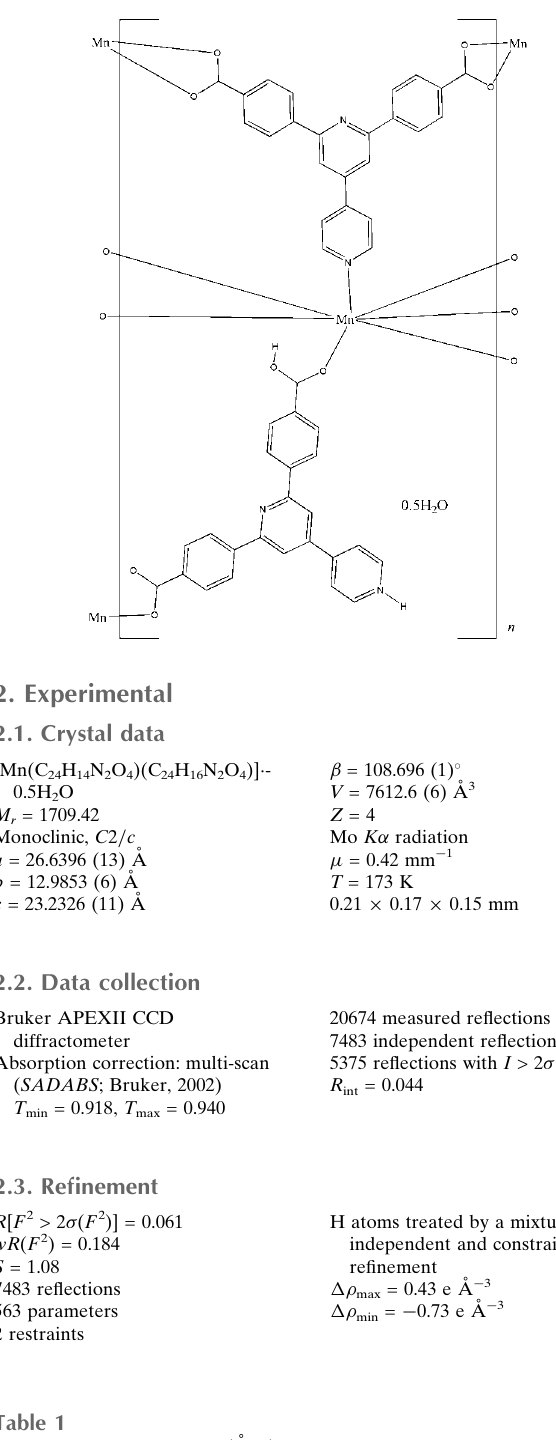
Hydrogen-bond geometry (A˚ , (cid:3)